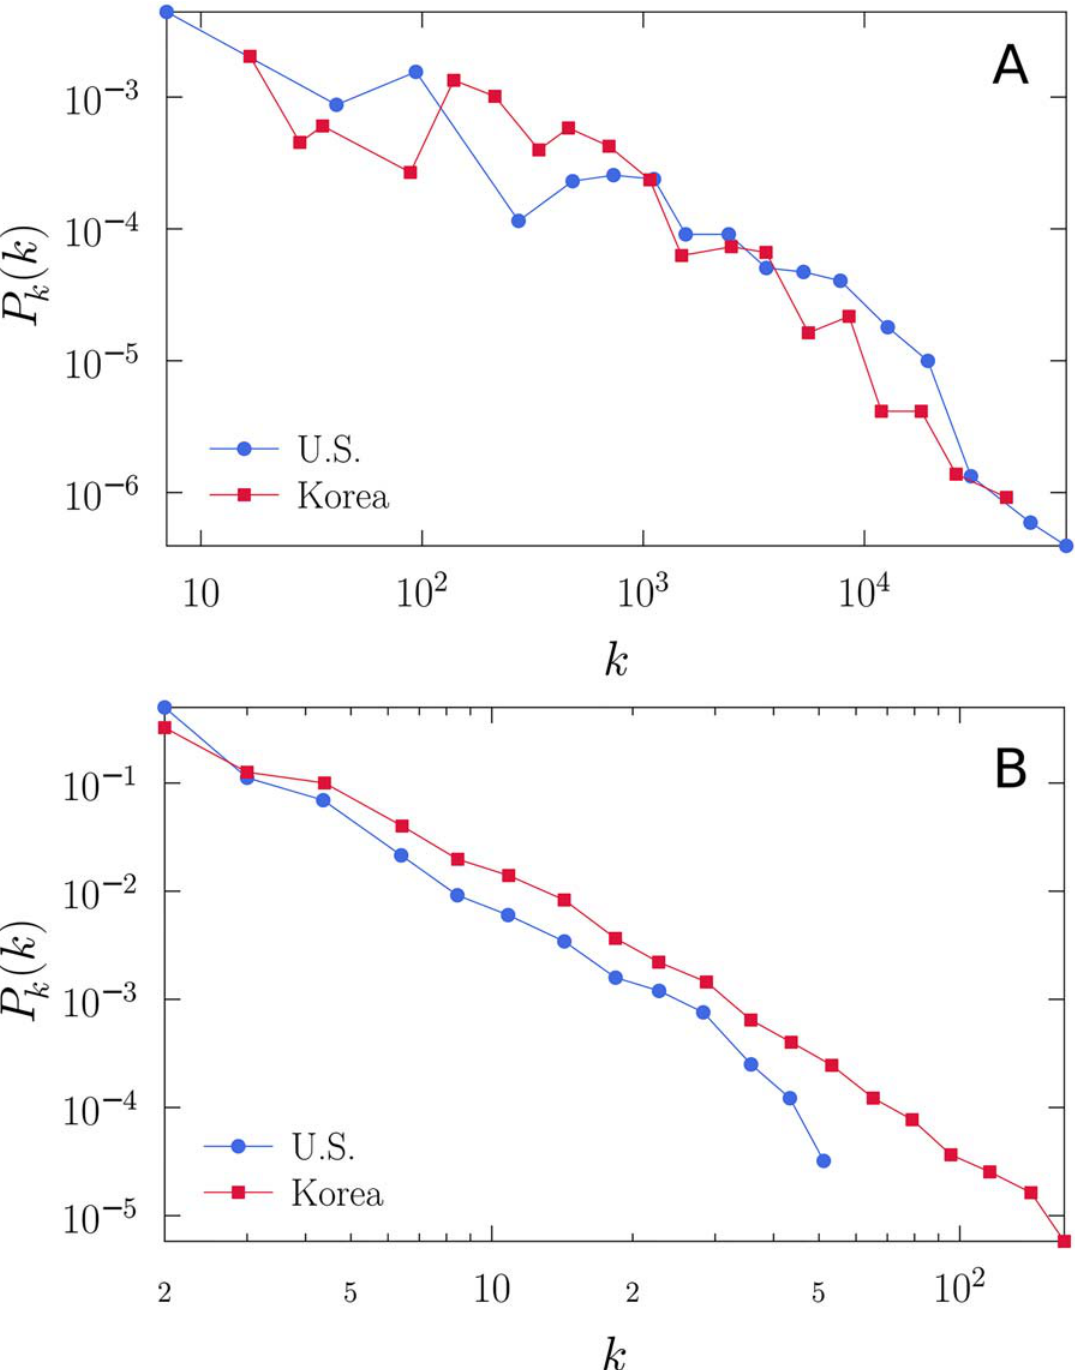
Fig 4. Degree distributions in the data. (A) The distribution of the number of Twitter followers for each legislator. (B) The distribution of the number of legislators that Twitter users follow. All distribtuions are heavy-tailed.